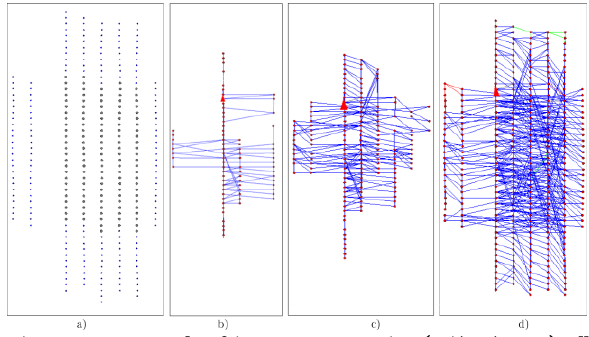
Figure 3: An example of image concatenation (Midas dataset): all perspective centers (a) and concateantion progresses (b-d) to derive the final connectivity graph of the image block (d).